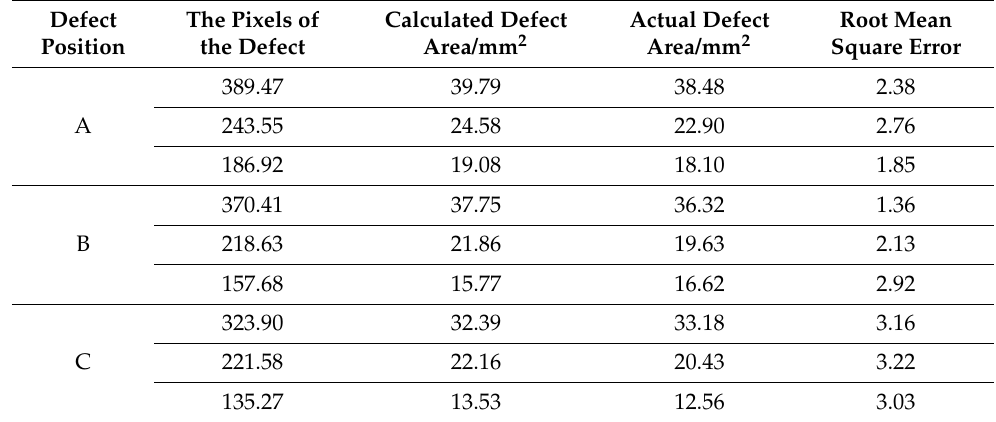
Table 3. Calculation results of defect area.